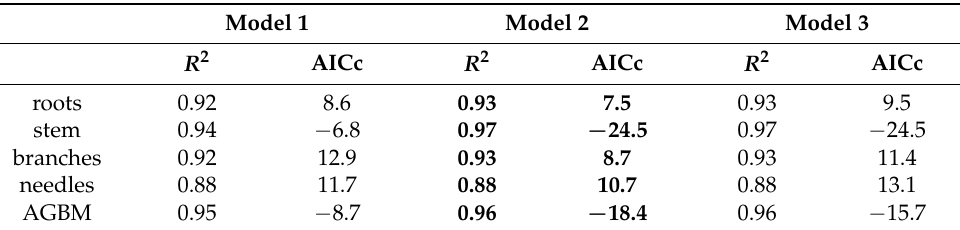
Table 5. Comparison of fitting performances ( R 2 and AICc) of the three models for needles, branches, stem, roots and aboveground biomass (AGBM) in planted Jack pine ( n = 28) trees. R 2 and AICc values of the best model are shown in bold for each compartment.